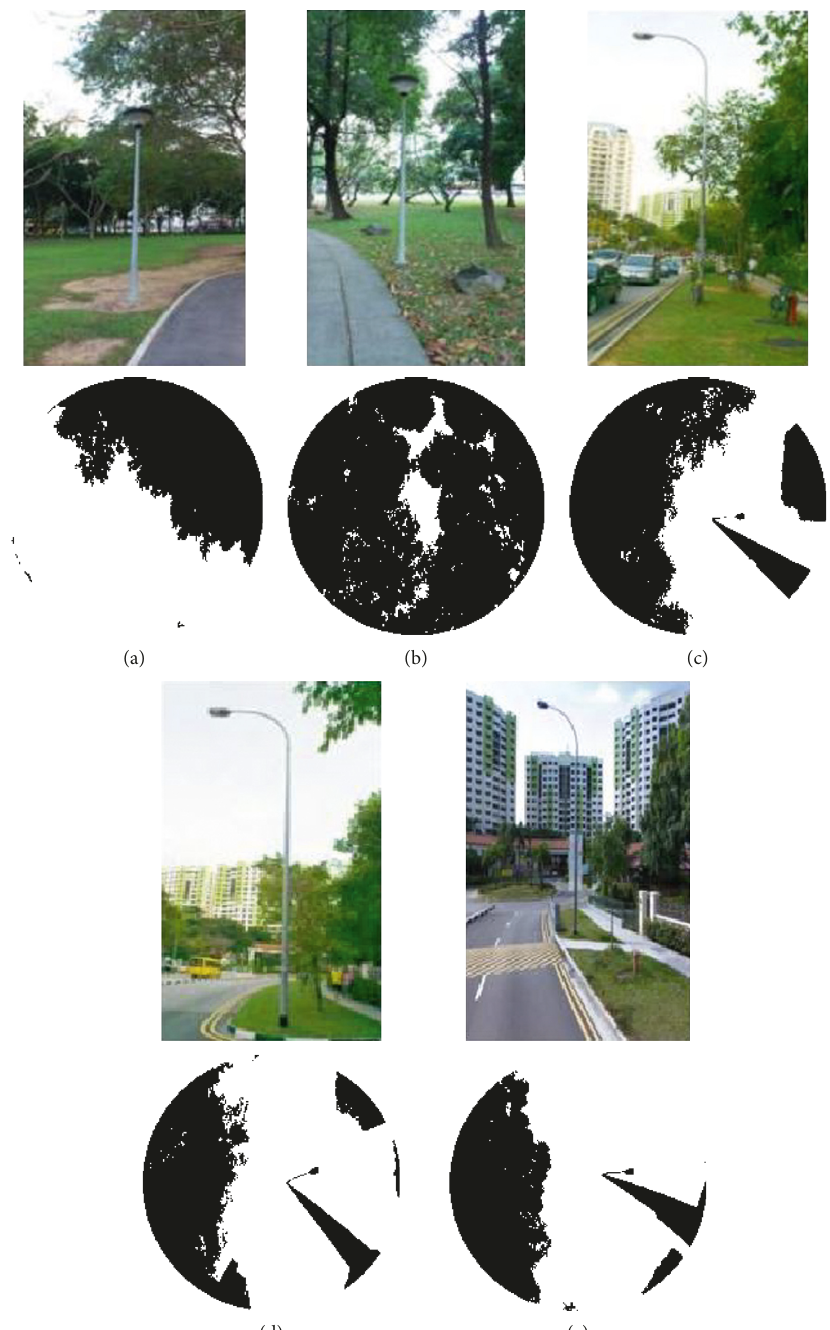
Figure 2: Photos and fisheye photos for each location (measurements were taken at 2.0 m above the ground level). (a) Point 1 (SVF � 0.61). (b) Point 2 (SVF � 0.17). (c) Point 3 (SVF � 0.48). (d) Point 4 (SVF � 0.66). (e) Point 5 (SVF �